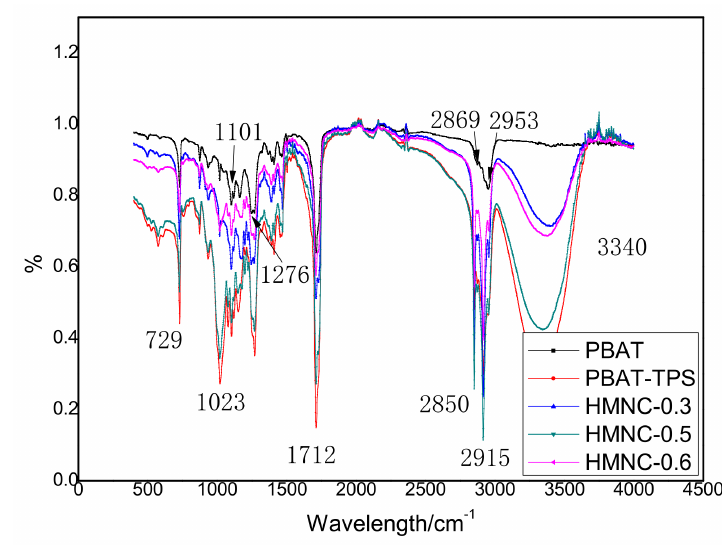
Figure 1. The FT-IR spectrum of